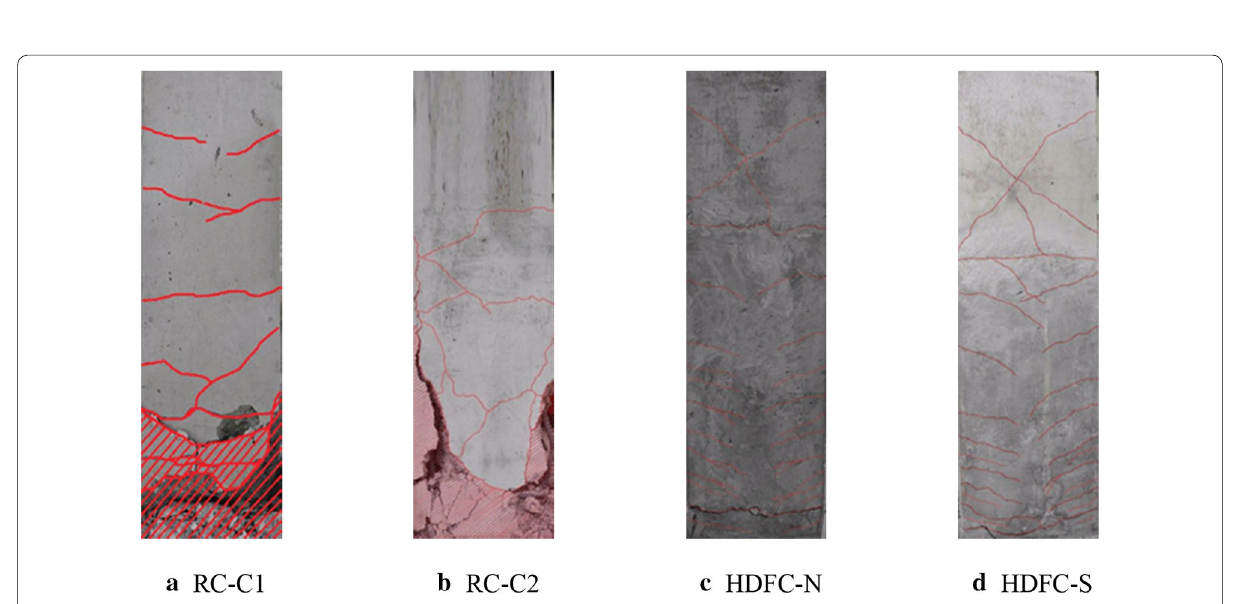
Fig. 10 Failure patterns on the front